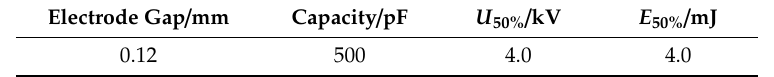
Table 1. Electrostatic sensitivity of the silicon‐based Cu(N 3 ) 2 @carbon nanotubes (CNTs) composite film. Electrode Gap/mm Capacity/pF U 50% /kV